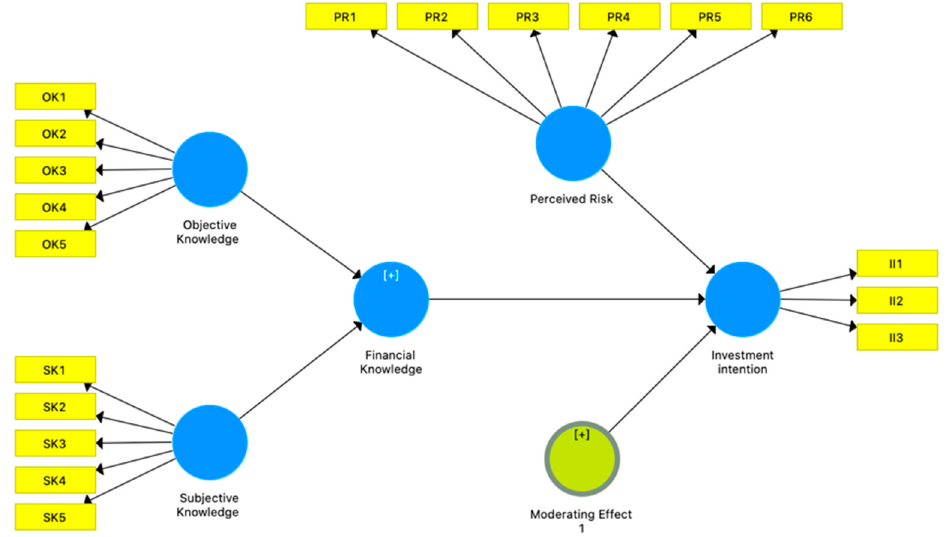
Figure 2. The measurement model. Source: Outputs of Smart PLS software considering the research framework and measurement.